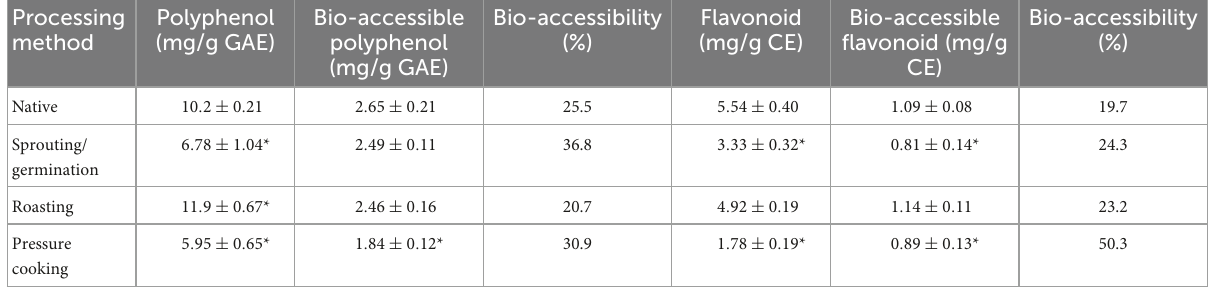
TABLE 2 Effect of various processing methods on bio-accessible content of finger millet polyphenols and flavonoids. Processing